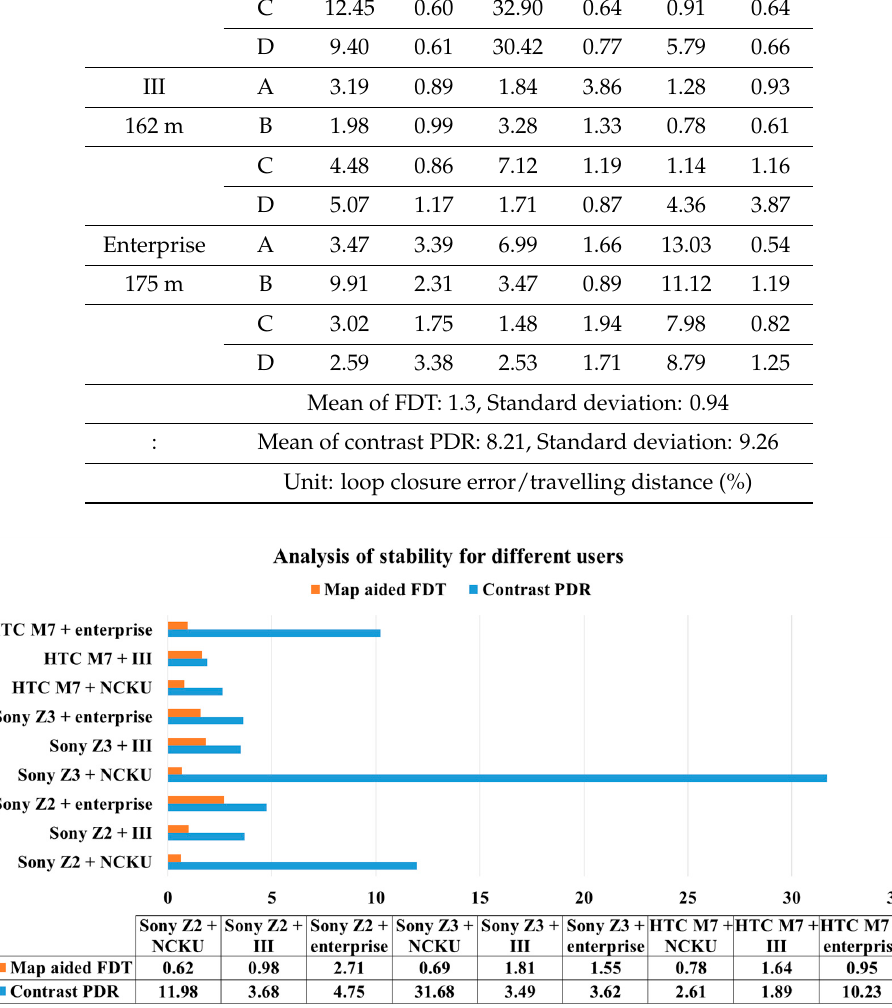
Table 5. The accuracy of FDT and contrast PDR system.